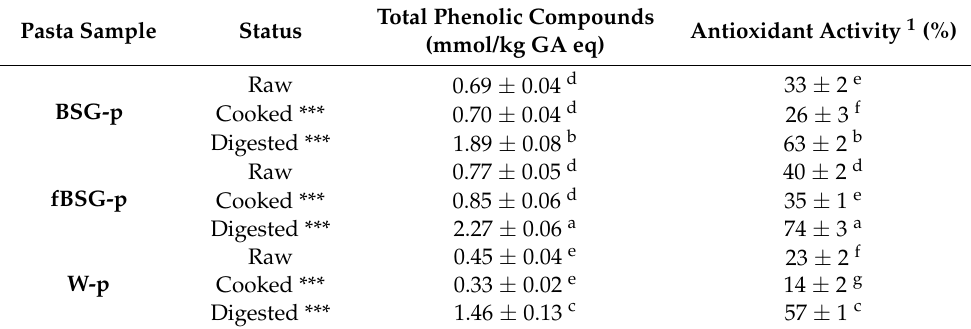
Table 5. Total phenolic compounds, expressed as mmol/kg of gallic acid (GA) equivalents, and antioxidant activity (radical scavenging activity on DPPH) of pasta containing fermented and native brewers’ spent grain: BSG-p, pasta containing native brewers’ spent grain (15% wt/wt in replacement of semolina); fBSG-p, pasta containing fermented brewers’ spent grain (15% wt/wt in replacement of semolina); W-p, pasta made with durum wheat